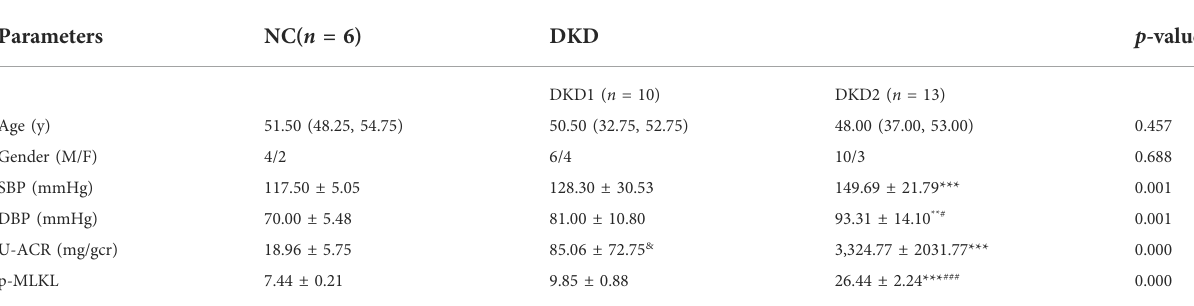
TABLE 2 The general characters of all